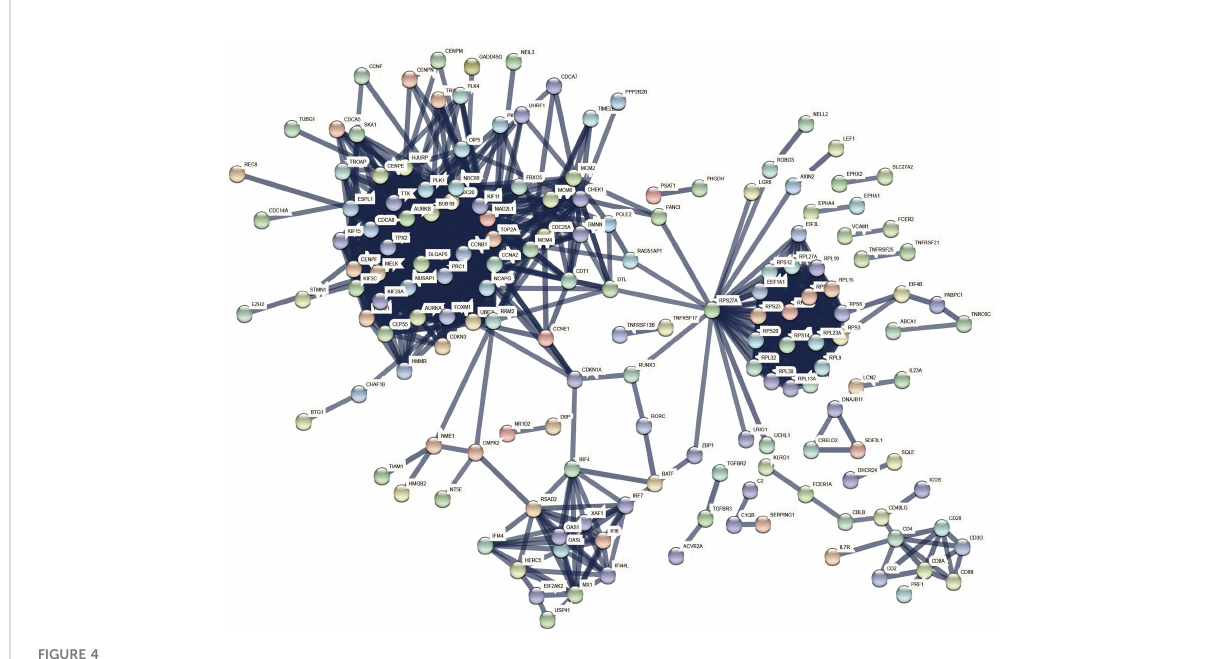
FIGURE 4 COVID-19 and HIV common differentially expressed genes in the PPI network.